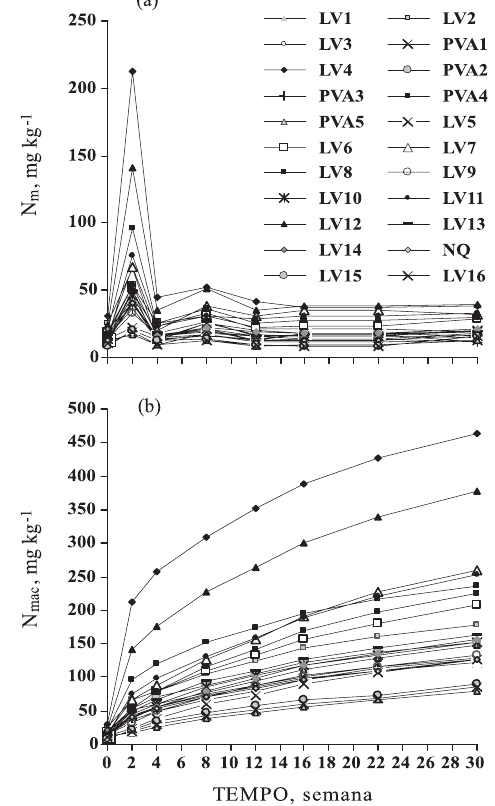
Figura 1. Nitrogênio mineralizado (N nitrogênio mineralizado acumulado (N em ensaio de incubação aeróbia de longa